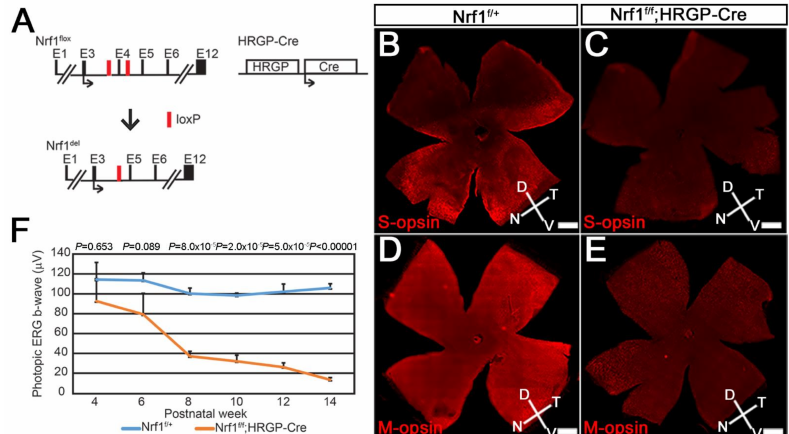
Figure 1. Nrf1 conditional knockout by HRGP-Cre causes impaired cone photoreceptor function. ( A ) Schematic diagram showing Nrf1 flox allele, Nrf1 -deleted allele and HRGP-Cre allele. Exons are indicated as E1–E12. Black arrows indicate the translational start sites for Nrf1 and Cre protein. Red boxes indicate loxP sites. ( B – E ) Immunostaining of 3-month-old Nrf1 f/+ ( B , D ) and Nrf1 f/f ;HRGP-Cre ( C , E ) flatmount retinas showing the expression of S-opsin ( B , C ) and M-opsin ( D , E ). ( F ) ERG of Nrf1 f/+ and Nrf1 f/f ;HRGP-Cre mice under light-adapted conditions. Scale bars: 500 µ m.